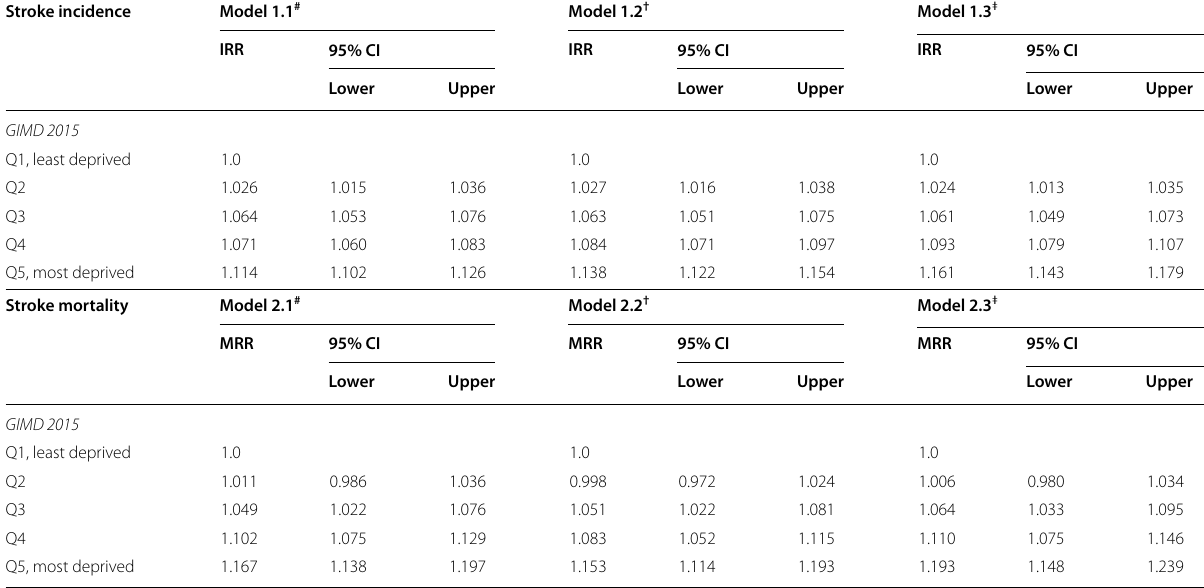
Table 2 Results of negative binomial regression analyses on GIMD 2015 for stroke incidence and mortality (period 2016–2019)